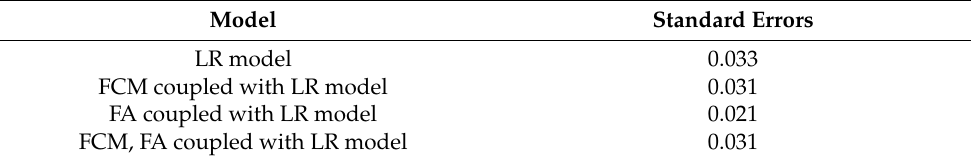
Table 15. Standard errors of each model.